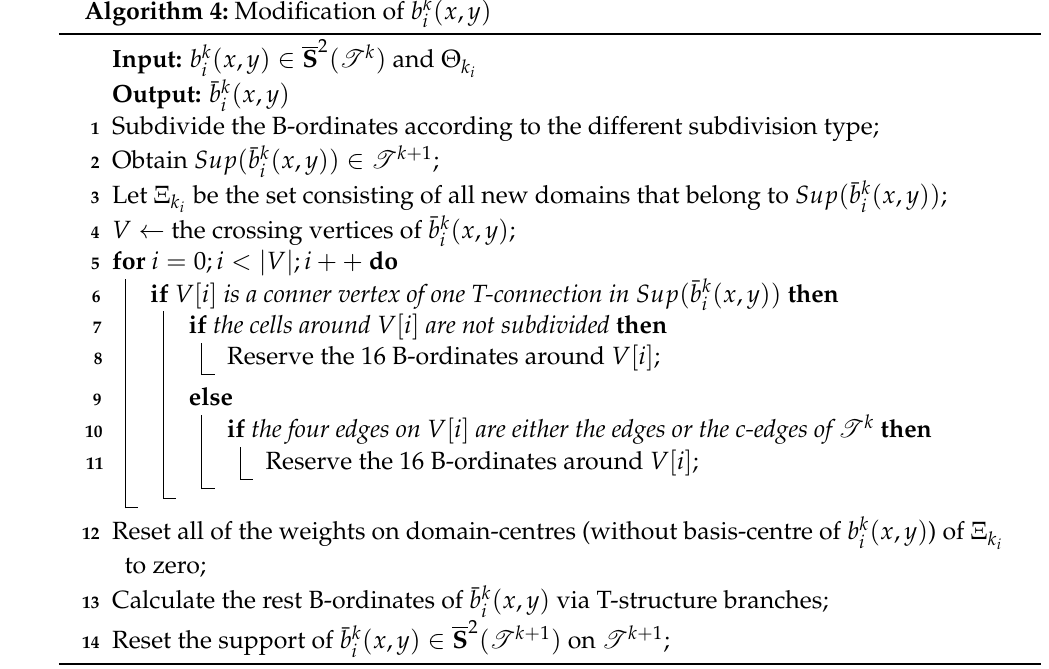
Algorithm 4: Modification of ¯ b k